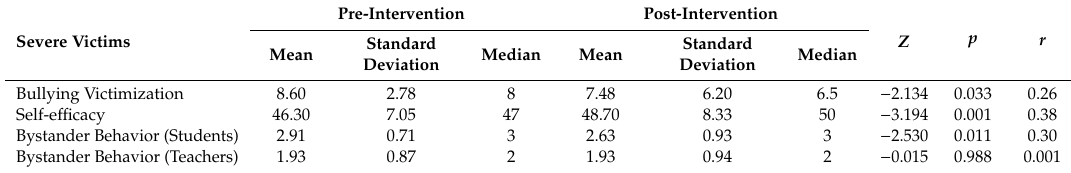
Table 3. Bullying victimization, self-e ffi cacy and the perceived bystanders’ behavior of the severe